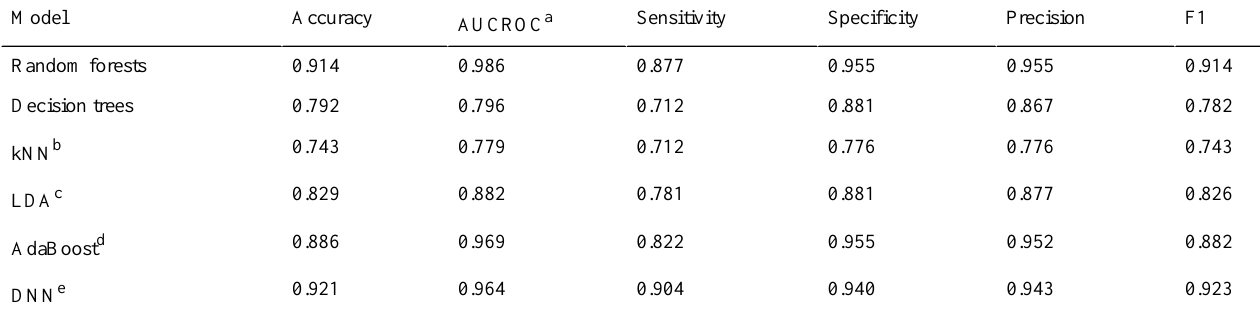
Table 3. Performance of each model with all features input.